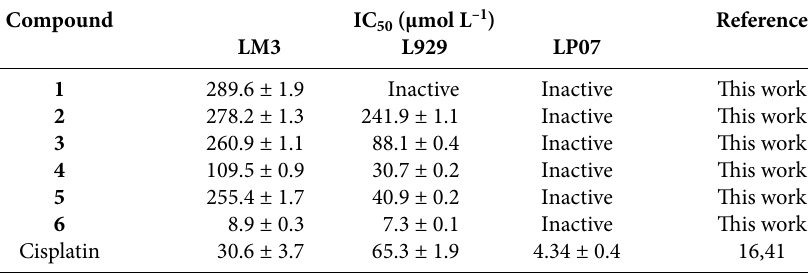
Table 3. Cytotoxicity (IC 50 ) of the coordination compounds 1 - 6 and cisplatin against murine LM3, L929 and LP07 cell lines.